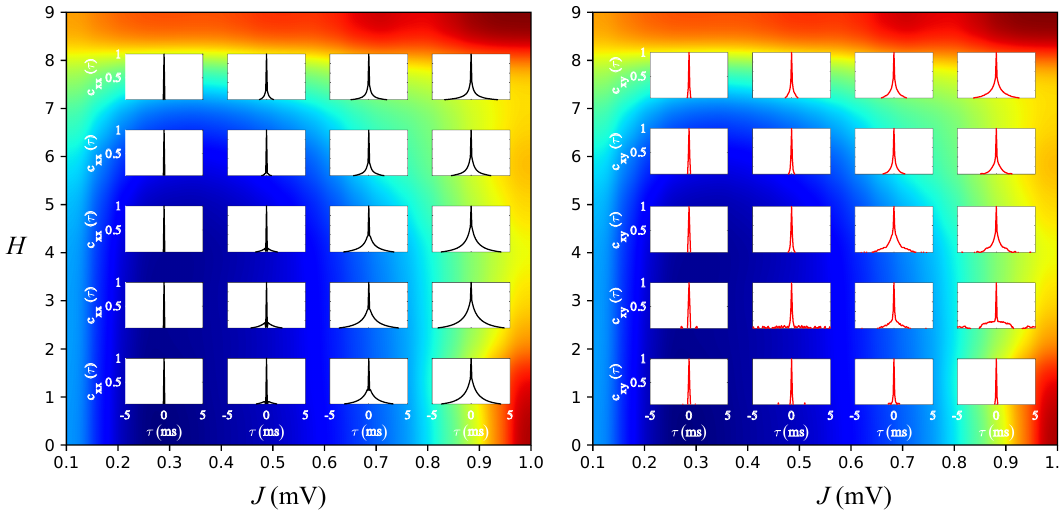
Figure 5. Spike-train autocorrelation c xx ( τ ) and cross-correlation c xy ( τ ) for selected pairs of parameters ( H , J ). Left: c xx . Right: c xy . The selected pairs ( J , H ) correspond to all possible combinations taken from the sets J = { 0.2,0.4,0.6,0.8 } and H = { 0,2,4,6,8 } . For better visualization, c xx and c xy for the pairs ( J , H ) are plotted over the plot of (cid:104) TE (cid:105) in the J - H diagram. The c xx is extracted from K = 10,000 randomly chosen neurons and the c xy from K = 10,000 randomly chosen pairs of